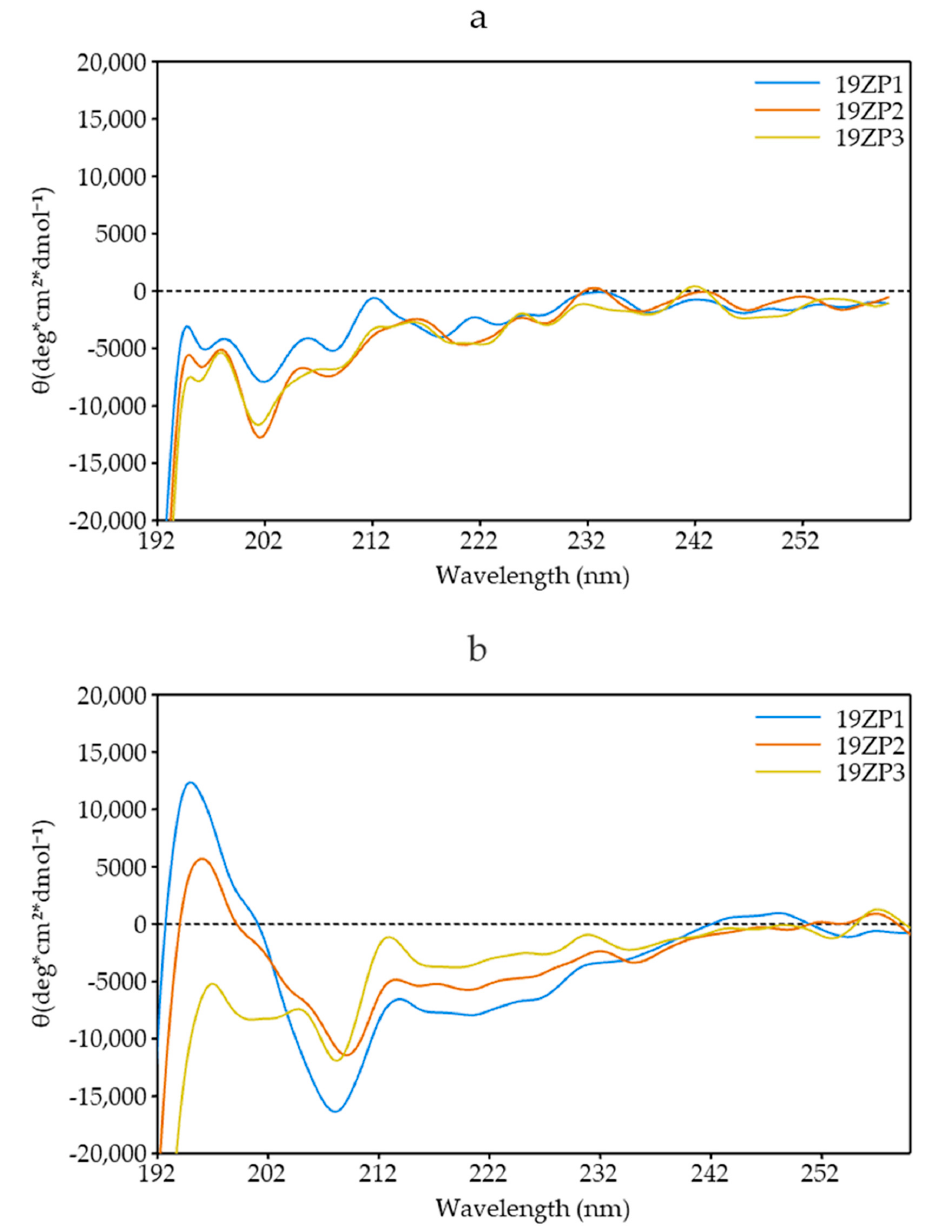
Figure 3. Structure of peptides analyzed by circular dichroism. The spectra were acquired at a peptide concentration of 5 µM in 10 mM phosphate buffer, pH 7.0 ( a ) and in 50% ( v / v ) trifluoroethanol in phosphate-buffered saline (PBS) ( b ).